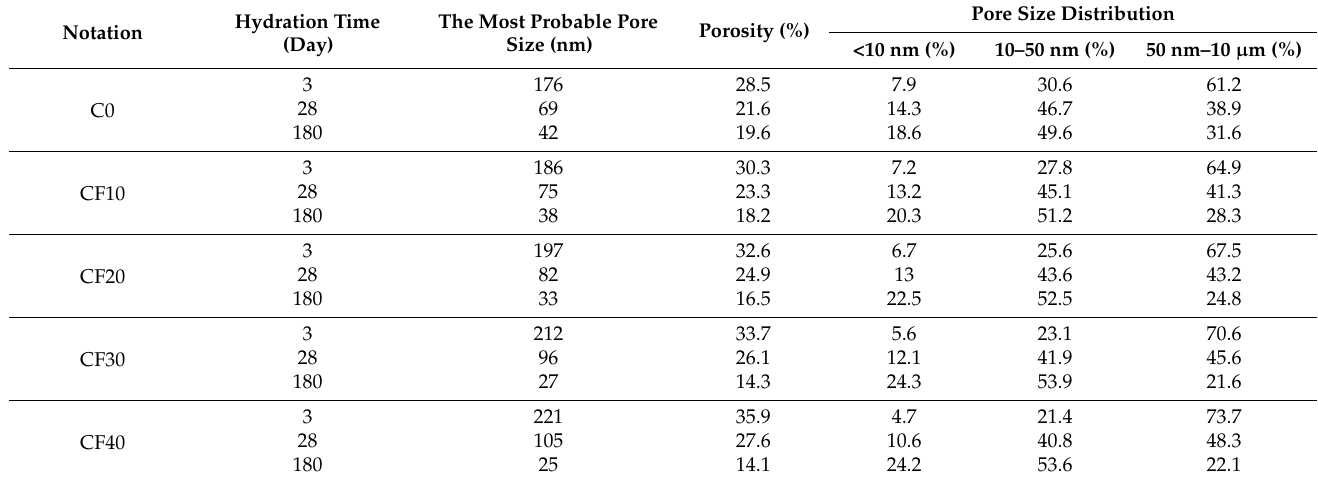
Table 4. Pore structures of face slab concretes added with various fly ash